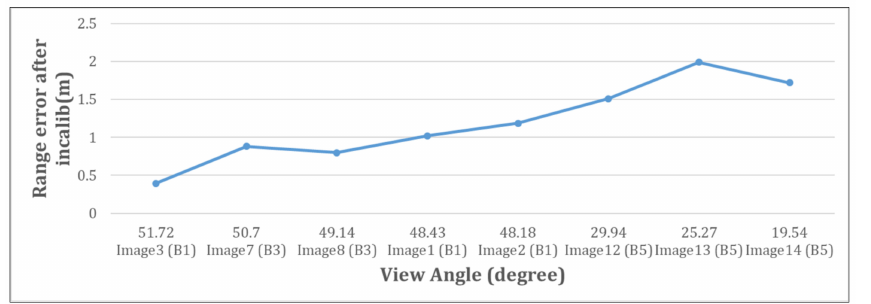
Figure 15. The relationship between side-looking angle and range positioning accuracy under field measurement elevation